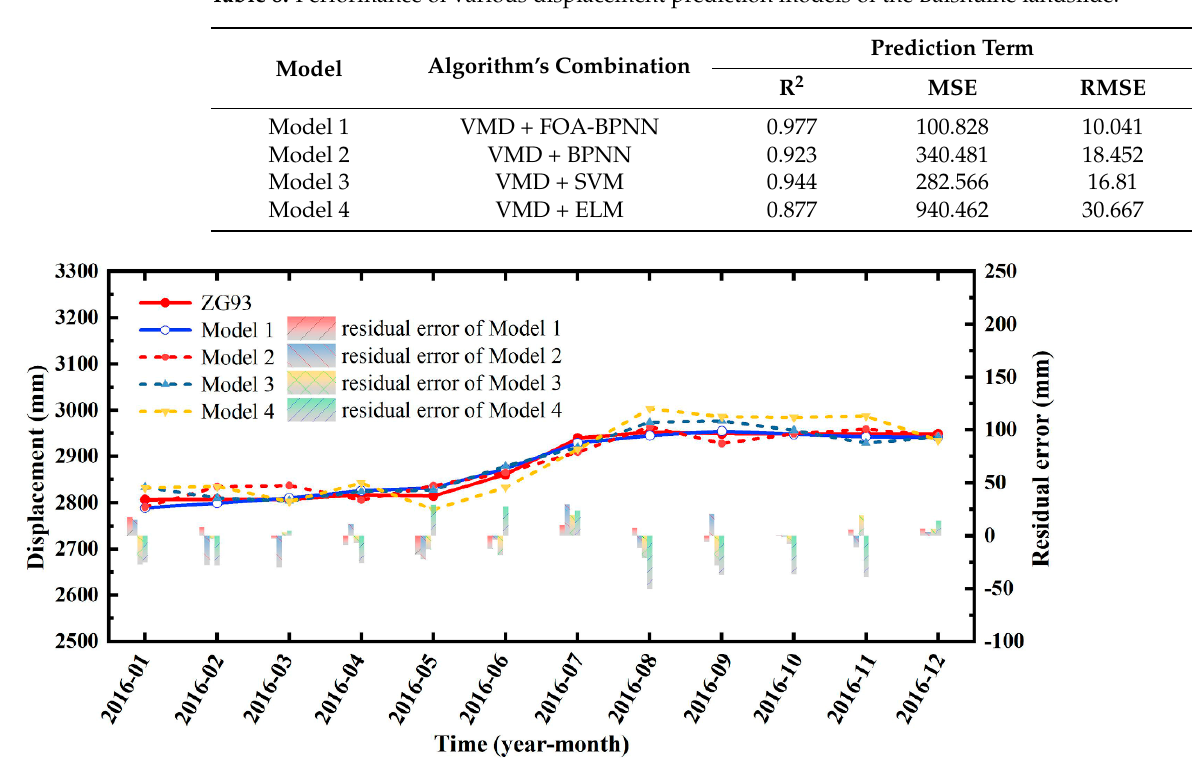
Table 8. Performance of various displacement prediction models of the Baishuihe landslide.